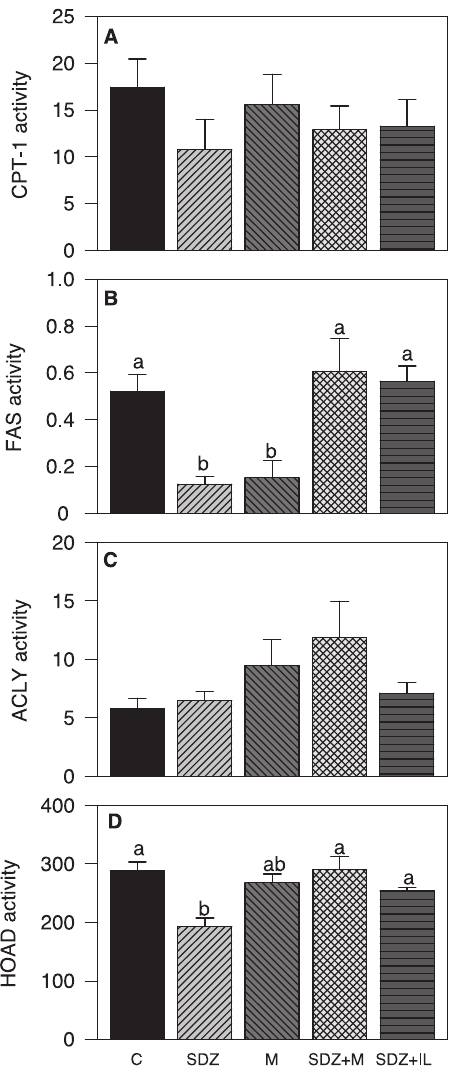
Figure 4. Changes in the activity of enzymes in hypothalamus after intraperitoneal treatment. Activities (mU.mg 2 1 protein) of CPT-1 (A), FAS (B), ACLY (C), and HOAD (D) in hypothalamus of rainbow trout after 6 h of intraperitoneal administration of 10 mL.Kg 2 1 of saline solution alone (control, C) or containing SDZ WAG 994 (SDZ, 60 m g.Kg 2 1 ), metyrapone (M, 1 mg.Kg 2 1 ), both SDZ WAG 994 and metyrapone (SDZ + M), or both SDZ WAG 994 and intralipid (3 mL.Kg 2 1 ) solution (SDZ + IL). The results are shown as mean + S.E.M. of 10 fish per treatment. Different letters indicate significant differences ( P , 0.05) among